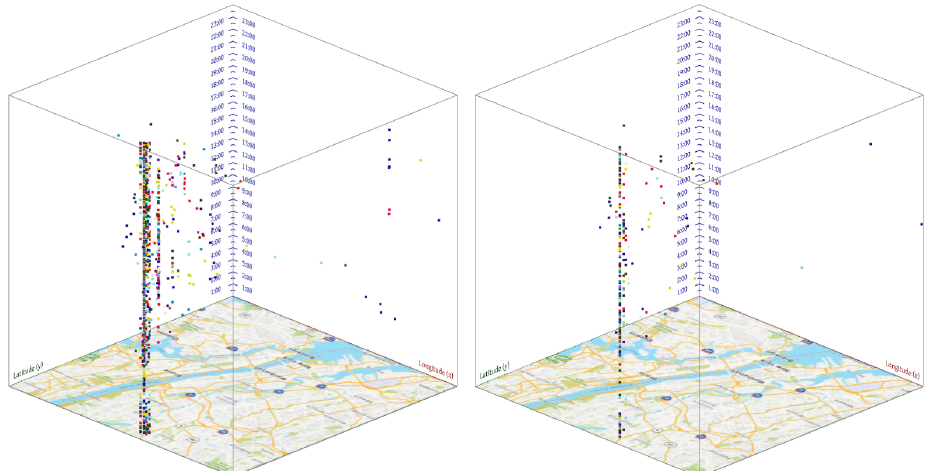
Figure 11. Foursquare check-ins for user 123456: on the ( left ), all activities; on the ( right ), restau- rant